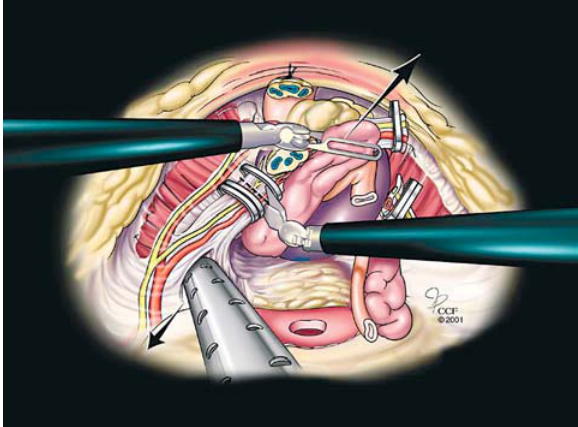
Figure 7 – Bladder neck has been dissected completely and vascular pedicle clipped and ready to be cut as show. Note that adequate traction of prostate (arrow) is important to bluntly peal the